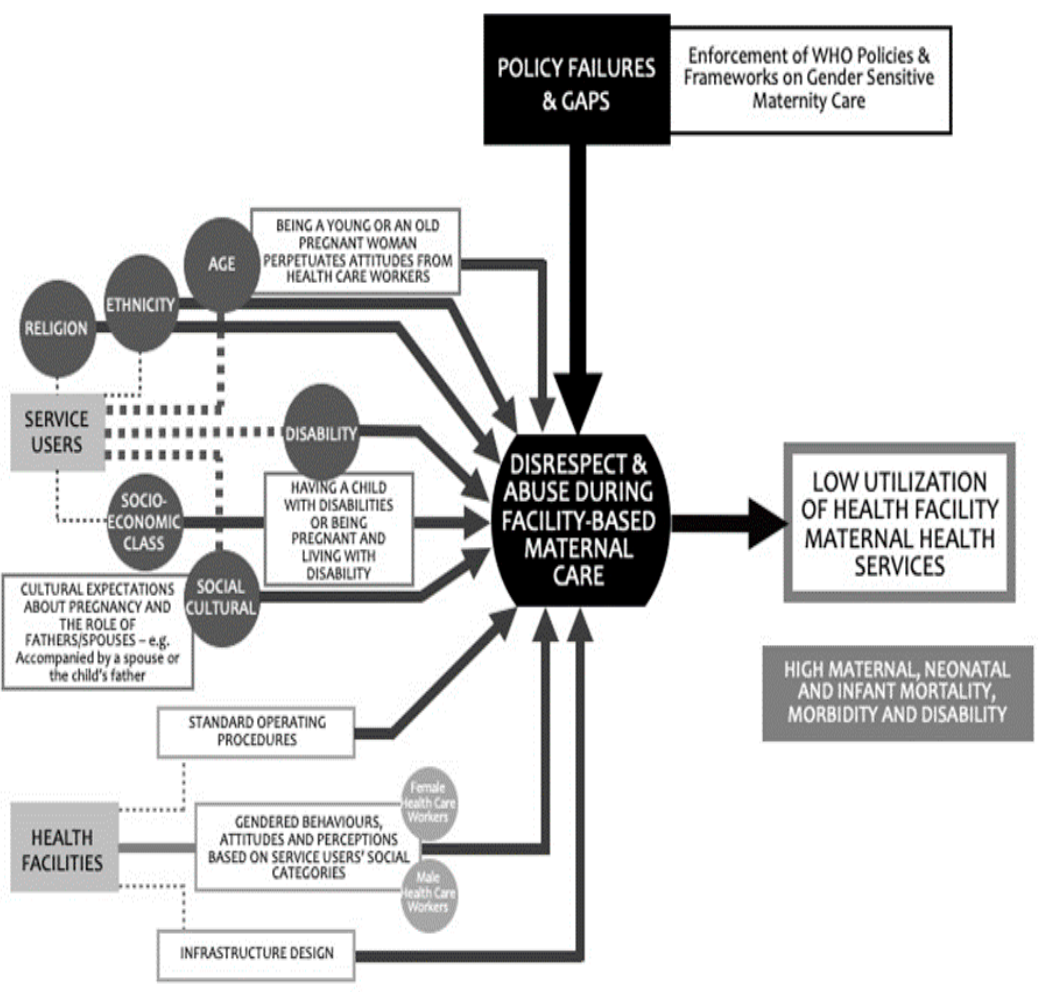
Figure 1. A summary of factors that influence disrespectful maternity care during facility care in sub-Saharan Africa (Lusambili et al., 2020) [1].